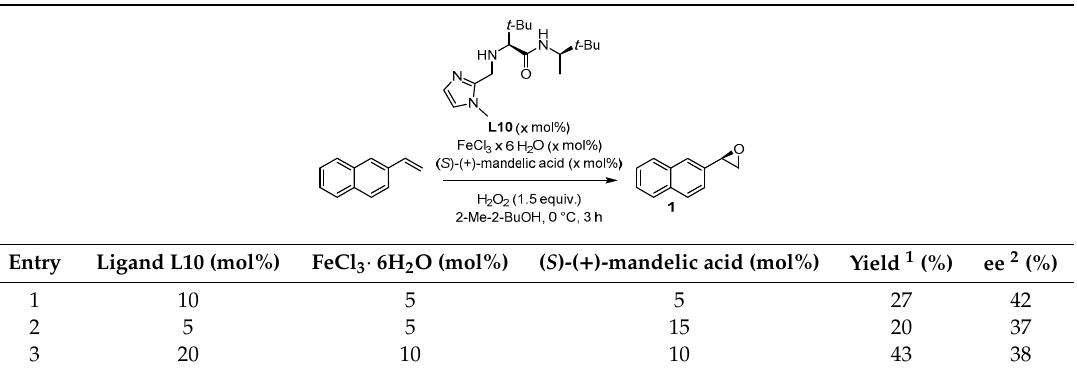
Molecules 2019 , 24 , x FOR PEER REVIEW Table1. Screeningofchiralpeptide-likeimidazole-basedligandsusing( S )-( + )-mandelicacidasadditive.